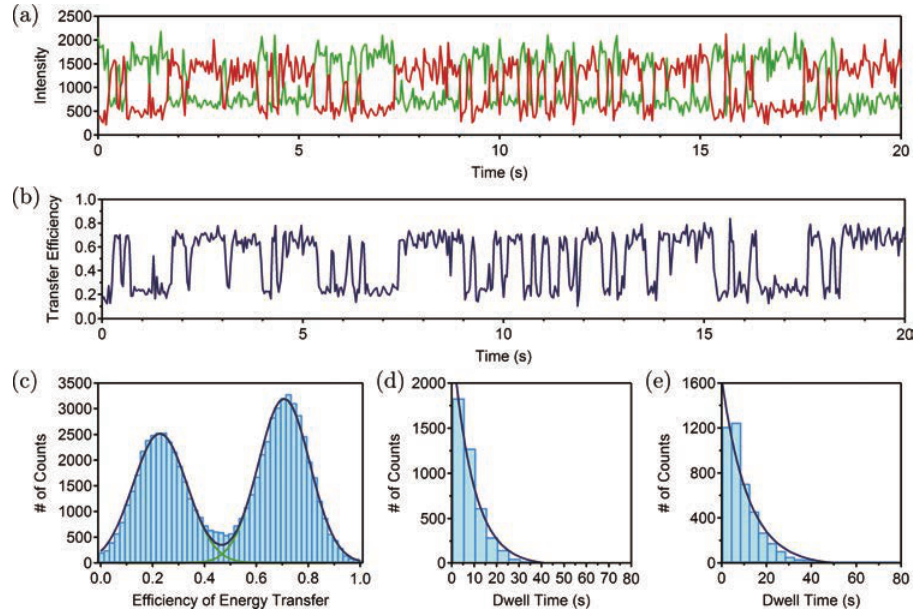
Fig. 2. (Color online) (a) Typical traces of sm-FRET experiments. Green and red traces refer to Cy3 and Cy5 signals, respectively. (b) The dependence of e±ciency of energy transfer on time. (c) The e±ciency of energy transfer distribution of BamHI – HJ. Green curves are Gaussian ¯ttings and dark blue curve is the sum of green curves. (d) The histogram for the dwell time at the \ isoII " state. Dark blue curve is exponential ¯tting. (e) The histogram for the dwell time at the \ isoI " state. Dark blue curve is exponential ¯tting. The data in (a) – (e) were collected in the absence of BamHI.